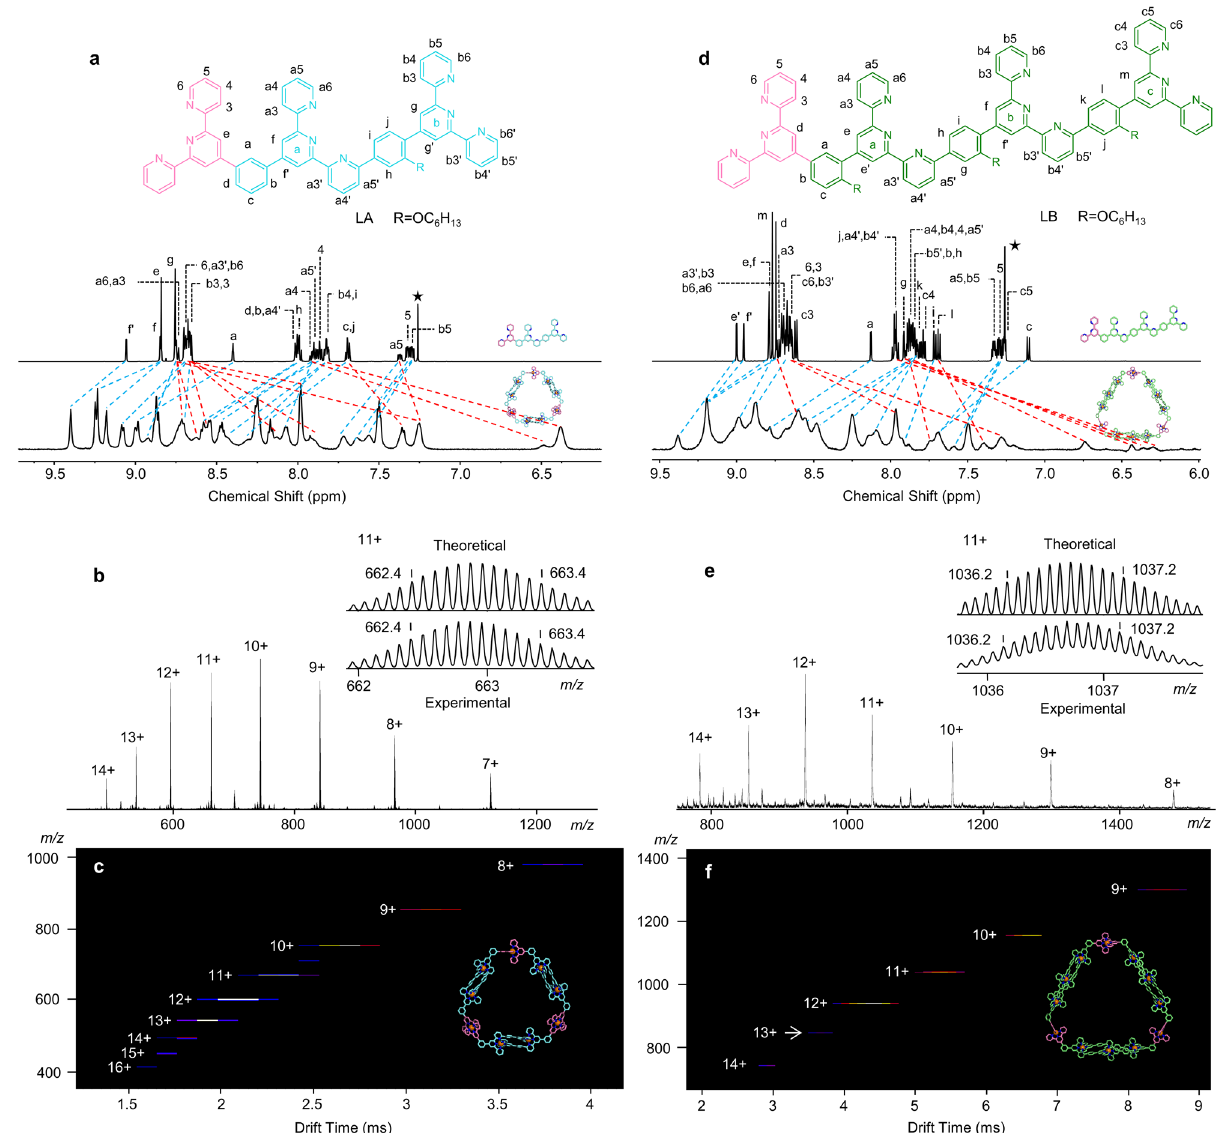
Fig. 5 Characterization of the hexagonal macrocycles Zn 9 (LA) 6 and Zn 12 (LB) 6 . a 1 H NMR spectra (600 MHz, 300 K) of ligand LA in CDCl 3 and